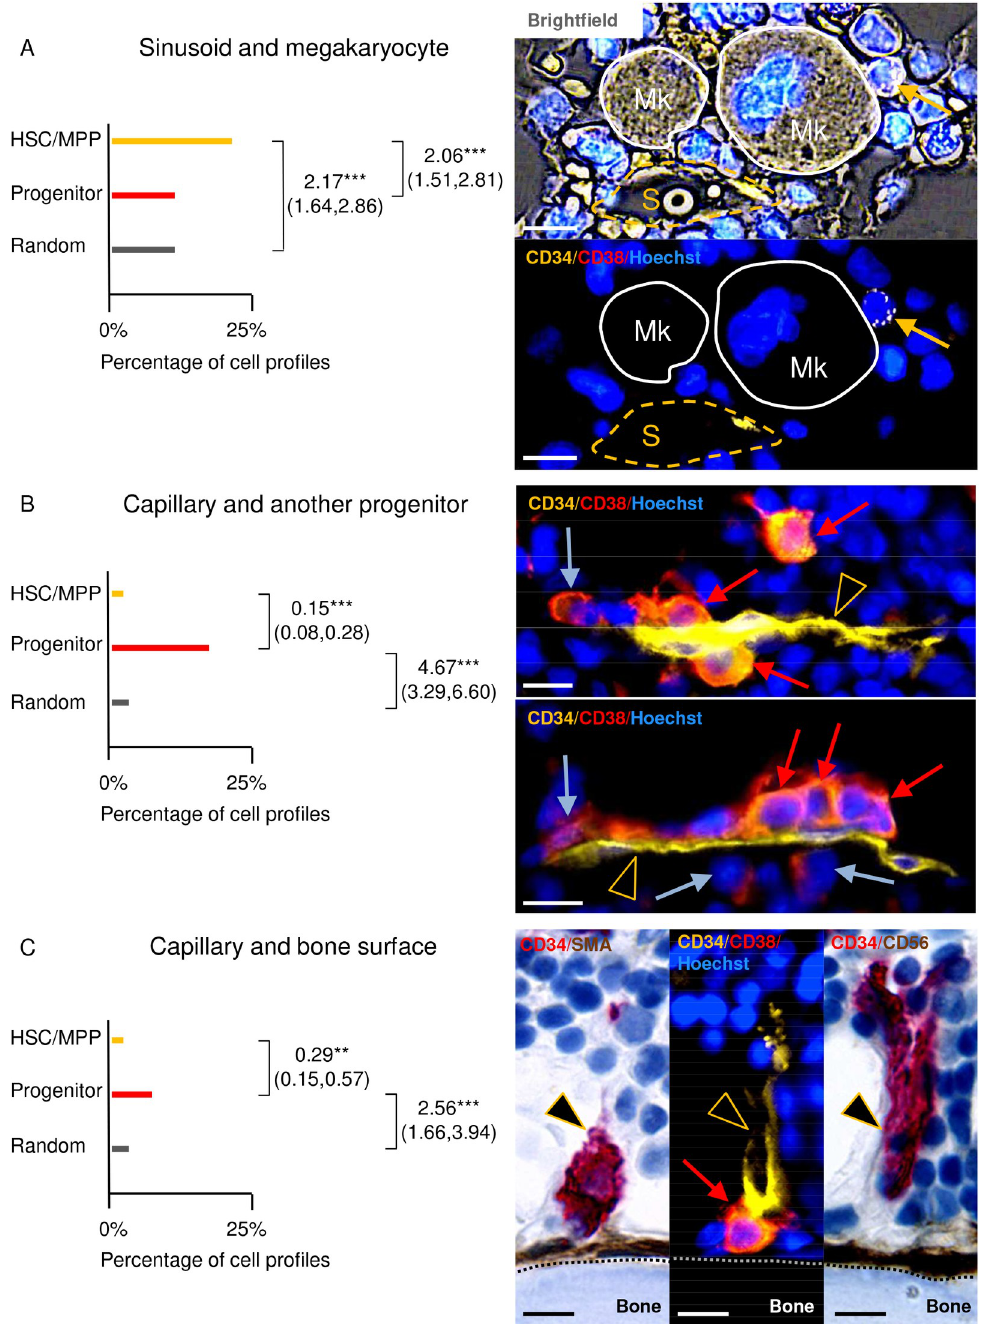
Fig 6. Relative likelihood of the HSCs/MPPs, the progenitors, and the random cell profiles to be in the presence of the indicated multicomponent BM components–and corresponding illustrations. (A, B, C graphs) The horizontal lines show the percentage of situations where a sinusoid and a megakaryocyte (A), a capillary and a progenitor (B), or a capillary and a bone surface (C) are respectively present within a distance of 30 μ m from HSCs/MPPs (yellow), progenitors (red), and random cell profiles (grey). The clustered logistic regression was used to compare the presence of the three multicomponent microenvironments within a distance of 30 μ m from each of the three cell categories. These comparisons were done in pairs: The HSCs/MPPs vs. the random cell profiles, the progenitors vs. the random cell profiles, and the HSCs/MPPs vs. the progenitors. The biopsy number was 10, and the cell profile number was 2791 (513 + 917 + 1361) when comparing the HSCs/MPPs and the progenitors to the random cell profiles, and 1430 (513 + 917) when comparing the HSCs/MPPs to the progenitors. When significant, the OR, the confidence interval, and the level